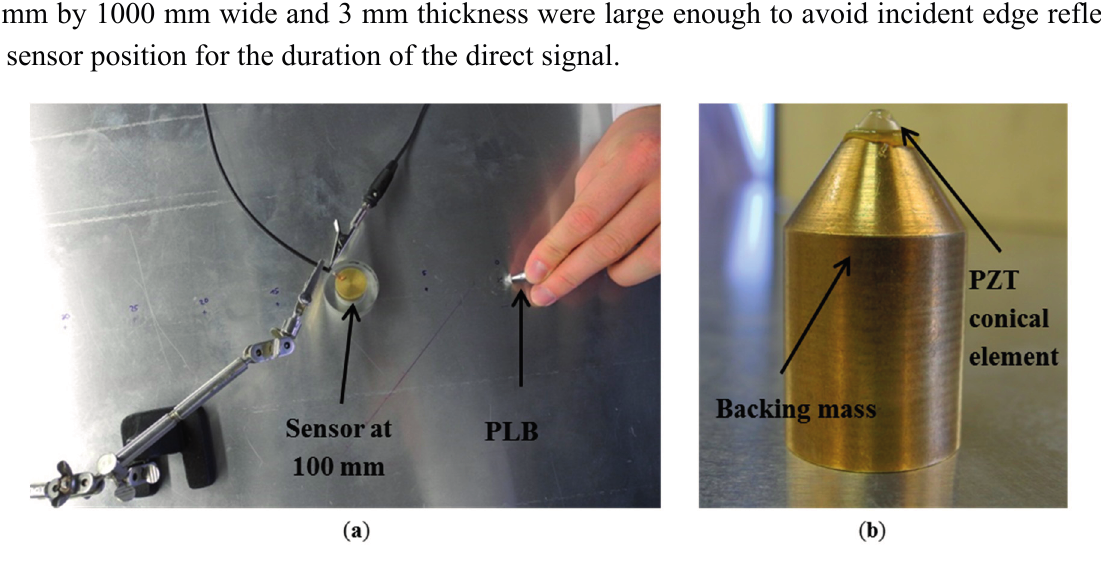
Figure 4. Photography of the experimental setup of the ( a ) plate and ( b ) details of the conical